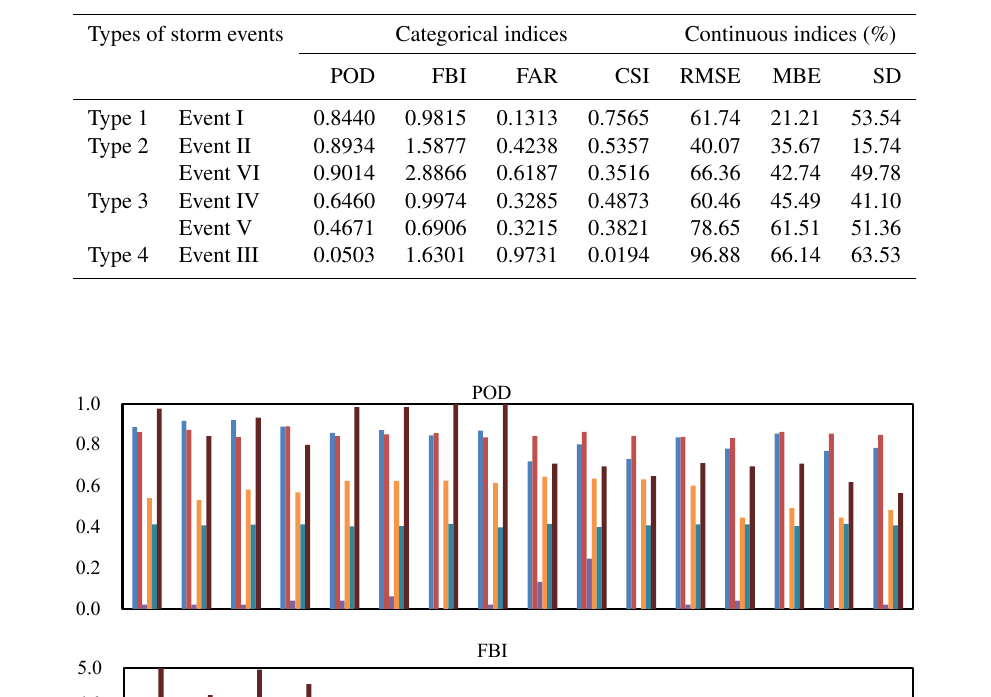
Table 7. Average index values of the 16 members of the physical ensemble for the simulations of the spatial rainfall distributions.